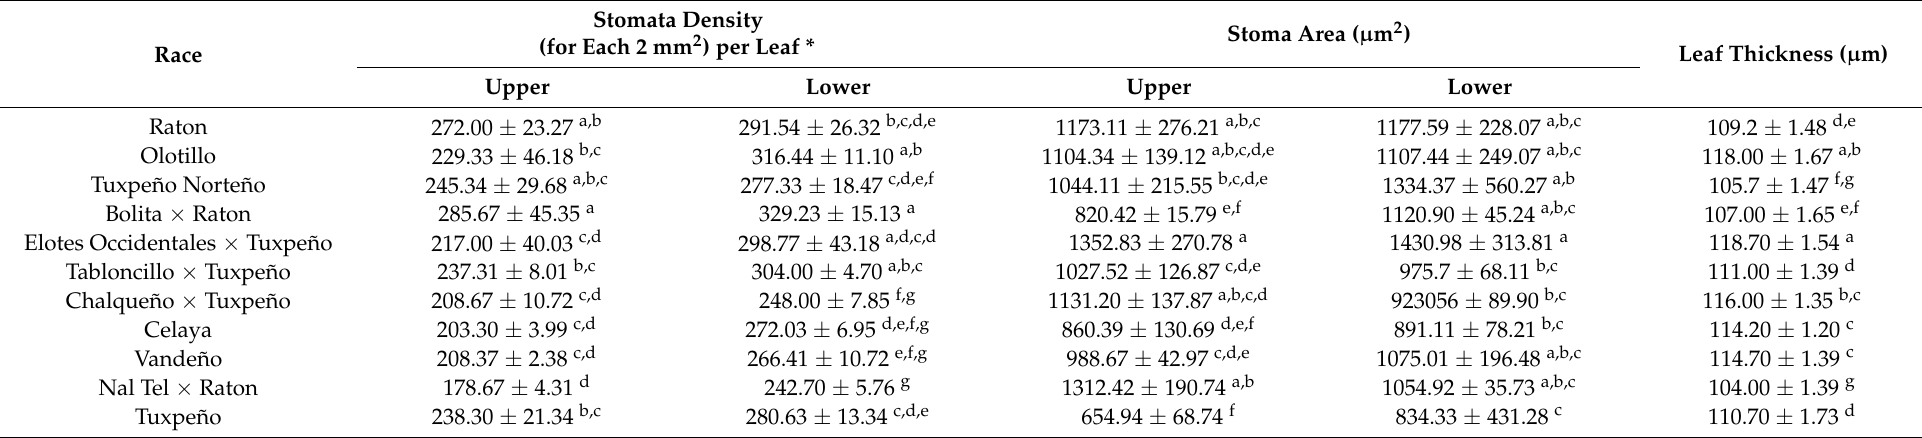
Table 3. Mean number of stomata (density) per leaf and stoma area, and leaf thickness of eleven races of